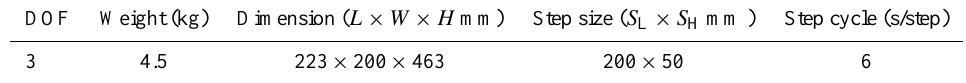
Table 1. Main specifications of LARM tripod leg mechanism DOF Weight (kg)